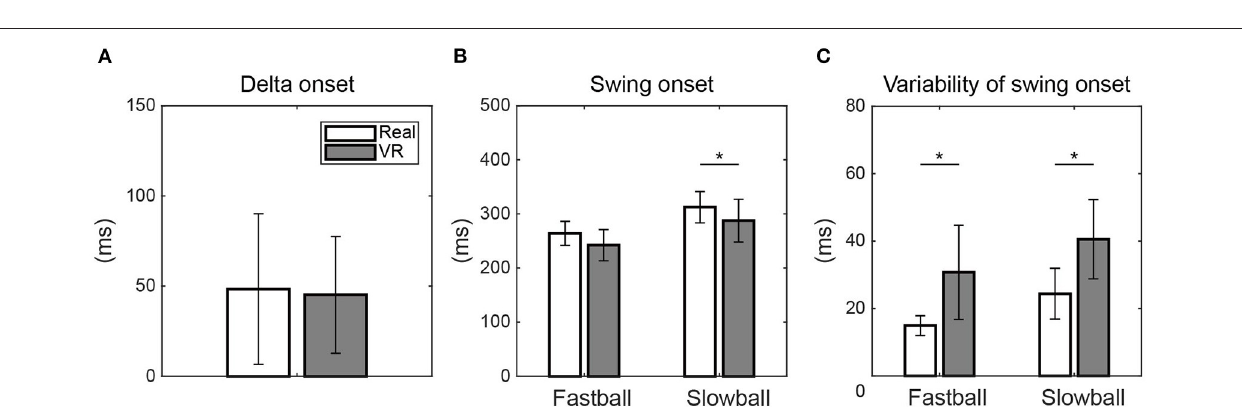
FIGURE 3 | The delta onset, swing onsets, and variabilities of swing onset. (A) The delta onset was not significantly different between the real and the VR environments. (B) The swing onset for slowball was significantly earlier in the VR environment than in the real environment (* p < 0.05). (C) The intra-individual variabilities (SDs) of swing onset for both pitch types were significantly larger in the VR environment than in the real